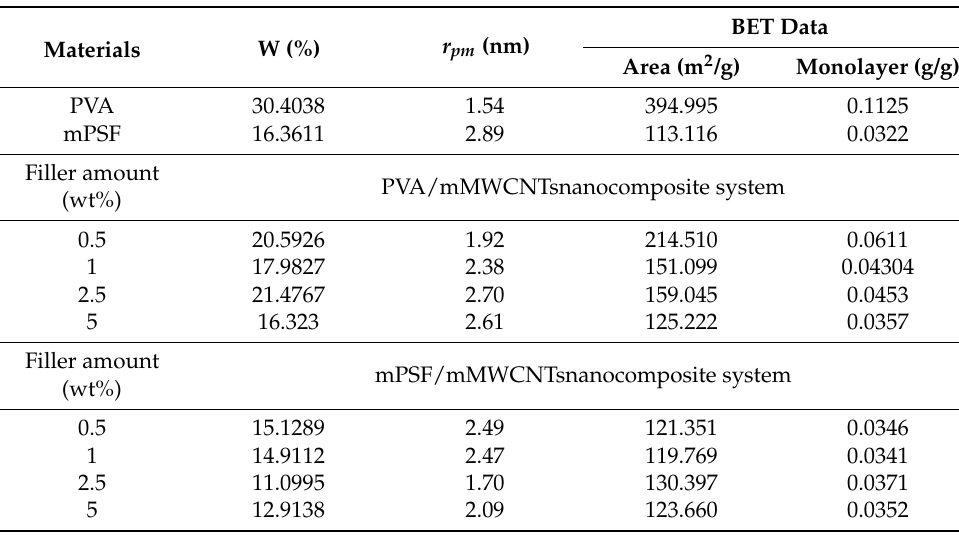
Table 4. The results of BET data for PVA, mPSF, and their corresponding